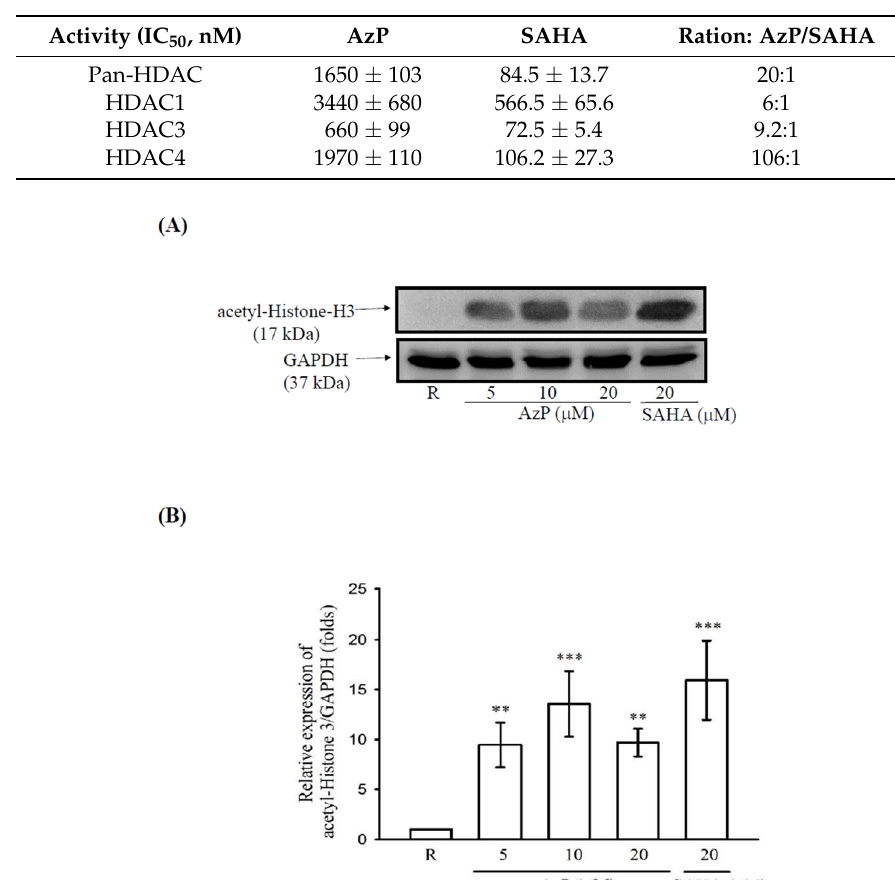
Table 1. Pan histone deacetylase (HDAC) enzyme activity, subtype HDAC1 activity, subtype HDAC3 activity and subtype HDAC4 activity treated with azatyrosine-phenylbutyric hydroxamides (AzP) and suberoylanilide hydroxamic acid (SAHA).